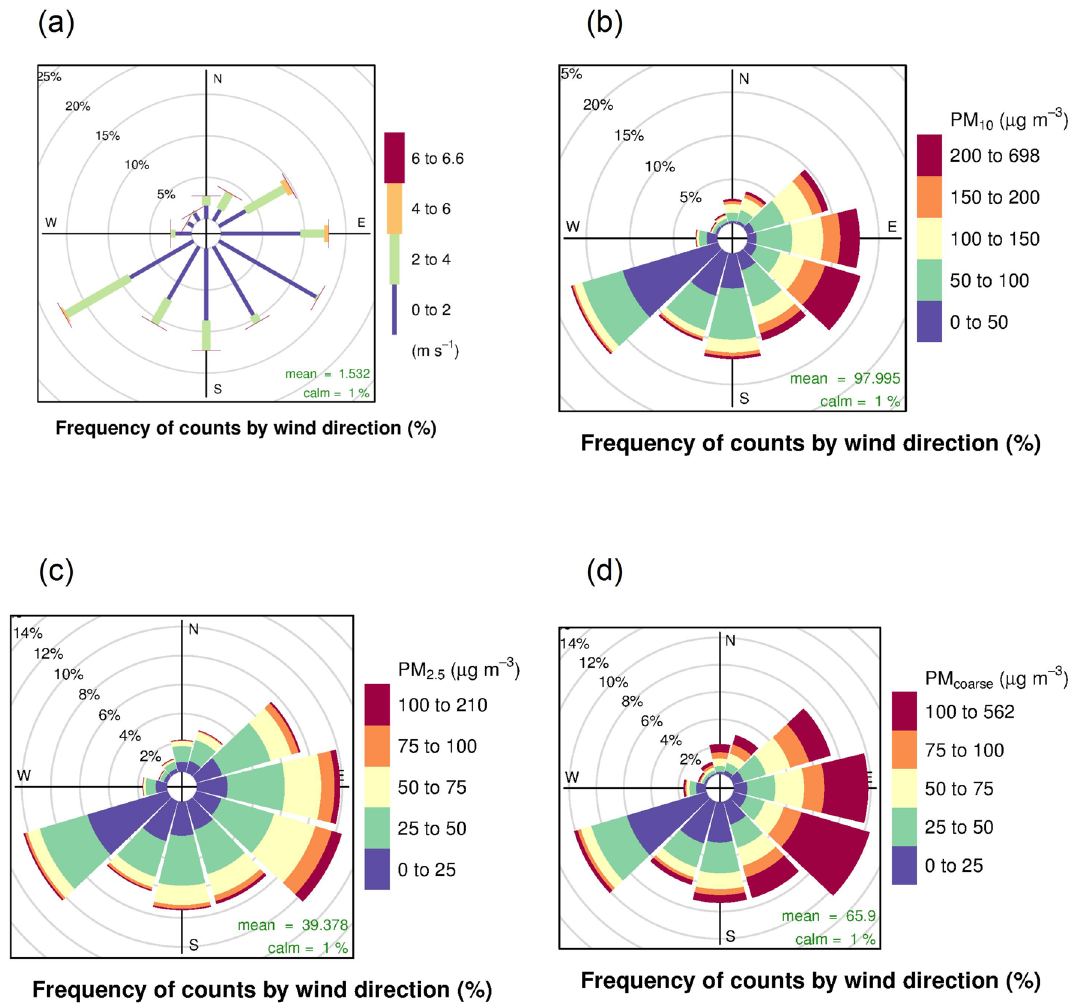
Figure 3. ( a ) Wind rose and pollution roses of ( b ) PM 10 , ( c ) PM 2.5 , and ( d ) PM coarse